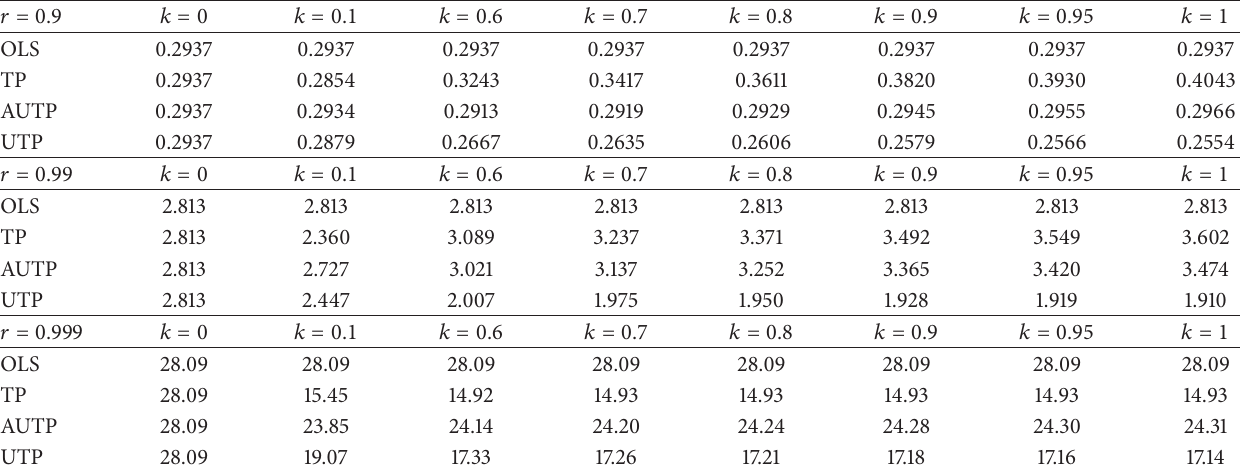
Table 2: Estimated MSE values of OLS, TP, AUTP, and UTP when 𝑛 = 25 , 𝑝 = 4 , and 𝜎 2 = 0.25 .